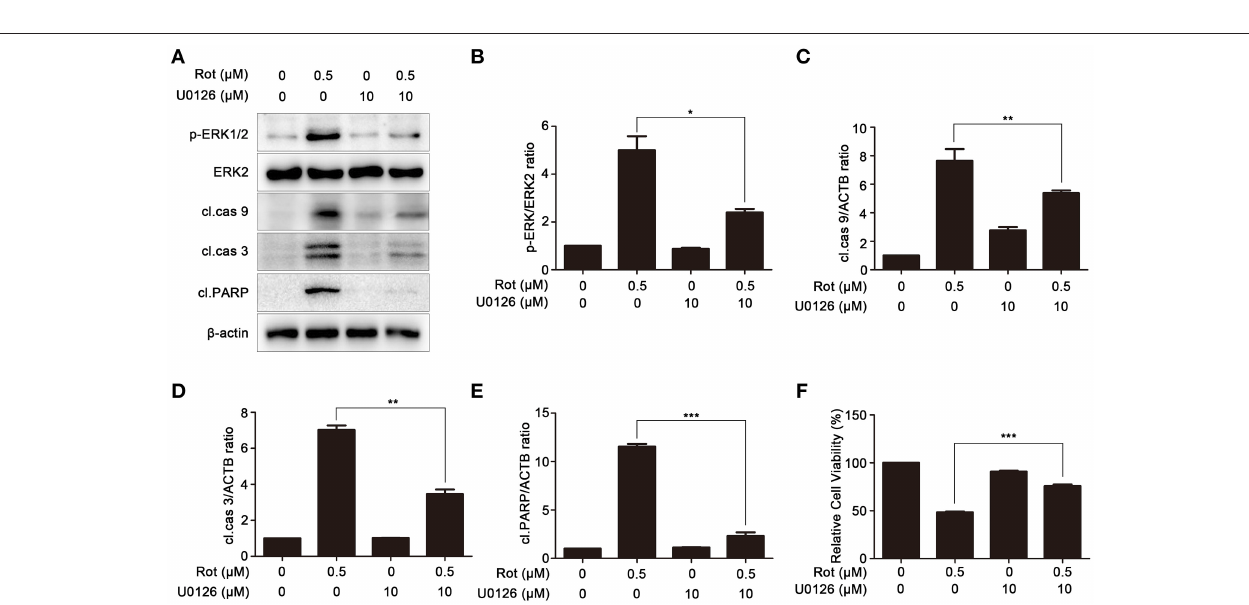
FIGURE 7 | Inhibition of ERK signaling prevents rotenone-induced apoptosis. (A) The SH-SY5Y cells were pretreated with U0126 (10 µ M) for 1h, and then treated with rotenone for 36h, cleaved PARP, p-ERK, ERK2 were detected by western blot, ERK2 was used as loading control, β -Actin was used as an internal control. Results are representative of at least three experiments. The levels of p-ERK (B) , cleaved caspase-9 (C) , cleaved caspase-3 (D) , cleaved PARP (E) were quantified by densitometry. * p < 0.05, ** p < 0.01, *** p < 0.001 vs. rotenone-treated group. (F) In the presence or absence of U0126, cells were treated with rotenone for 36h, cell viability was assessed by MTT assay. Data are expressed as percent of values in untreated control cultures. *** P < 0.001, compared with rotenone-treated